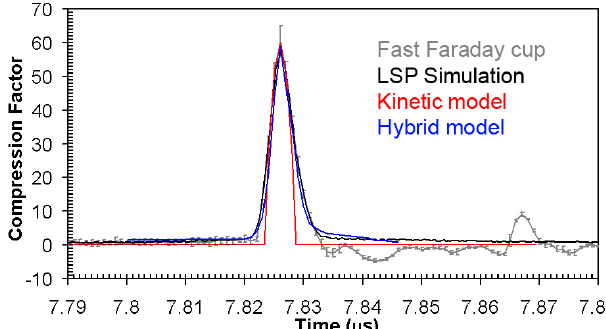
FIG. 10. (Color) Comparison of longitudinal current compres- sion at the focal plane between the experimental measurement using a fast Faraday cup (gray with error bars), LSP simulation (black), kinetic model (red), and hybrid model